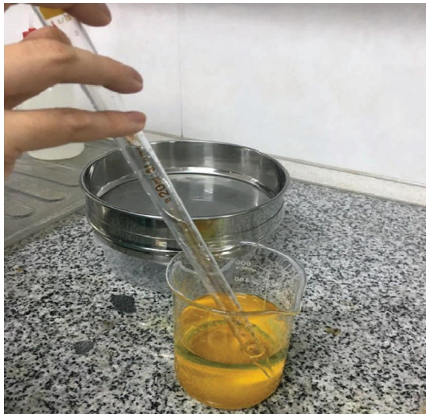
Figure 3: Collection of microplastic particles suspended in the liquid surface after sedimentation of sediments using a pipette and using a sieve for separation.